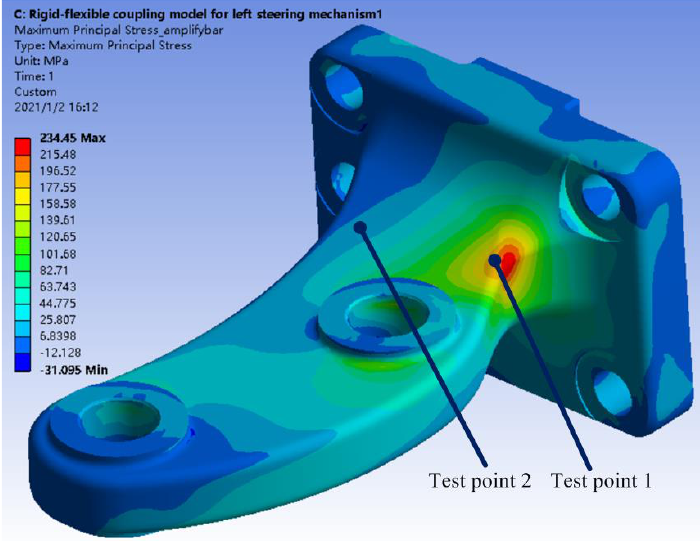
Figure 16. Stress distribution of the maximum principal stress on the steering